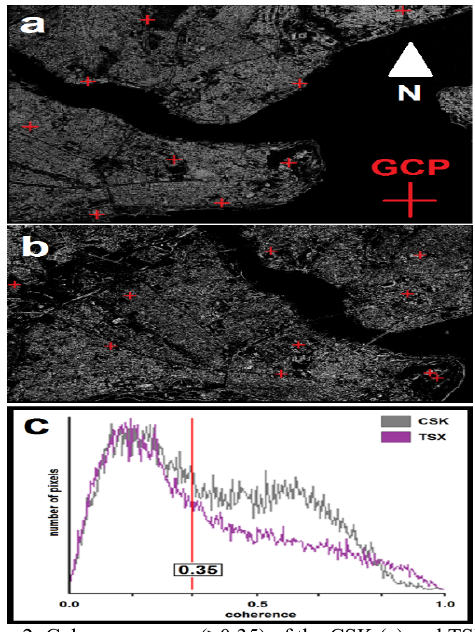
Figure 2. Coherence maps (≥0.35) of the CSK (a) and TSX (b) InSAR-pairs including used GCPs for orbital refinement and coherence histogram (c)